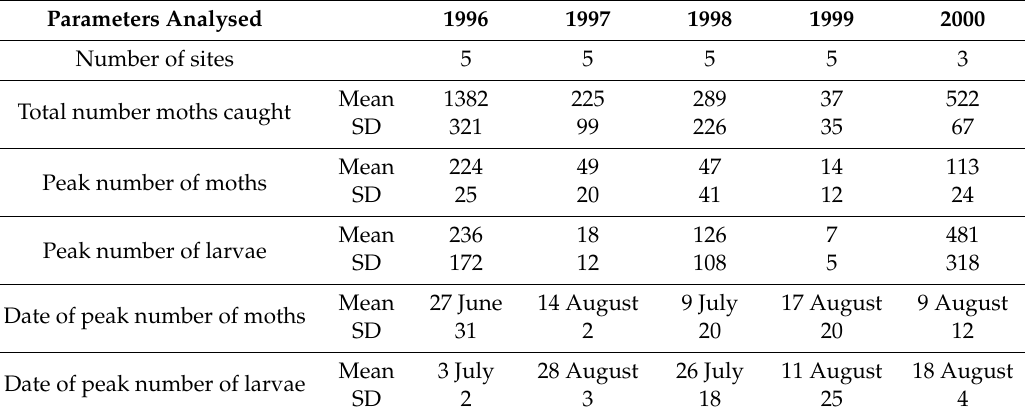
Table 1. Summary data from five locations in Lincolnshire, UK, in 1996–2000. Means and standard deviations (SD) are